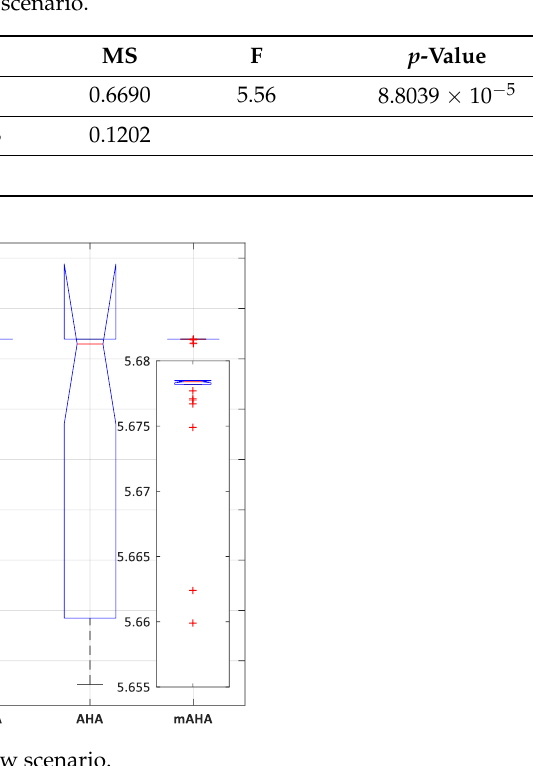
Figure 8. ANOVA ranking for first shadow scenario .